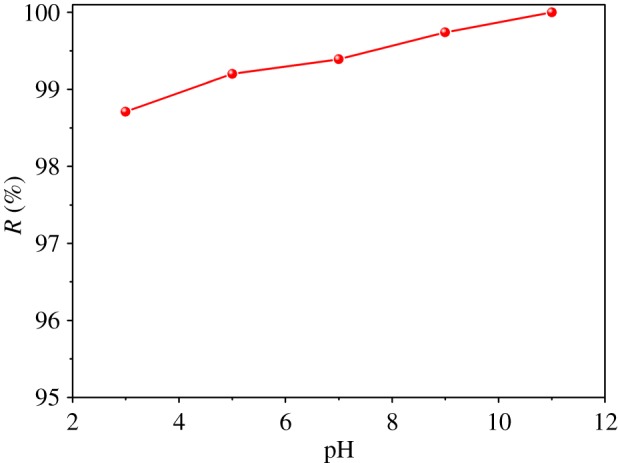
Effect of the pH on the removal of MB (C0 = 20 mg l−1, m = 10 mg, t = 60 min, T = 30°C, v = 100 ml).